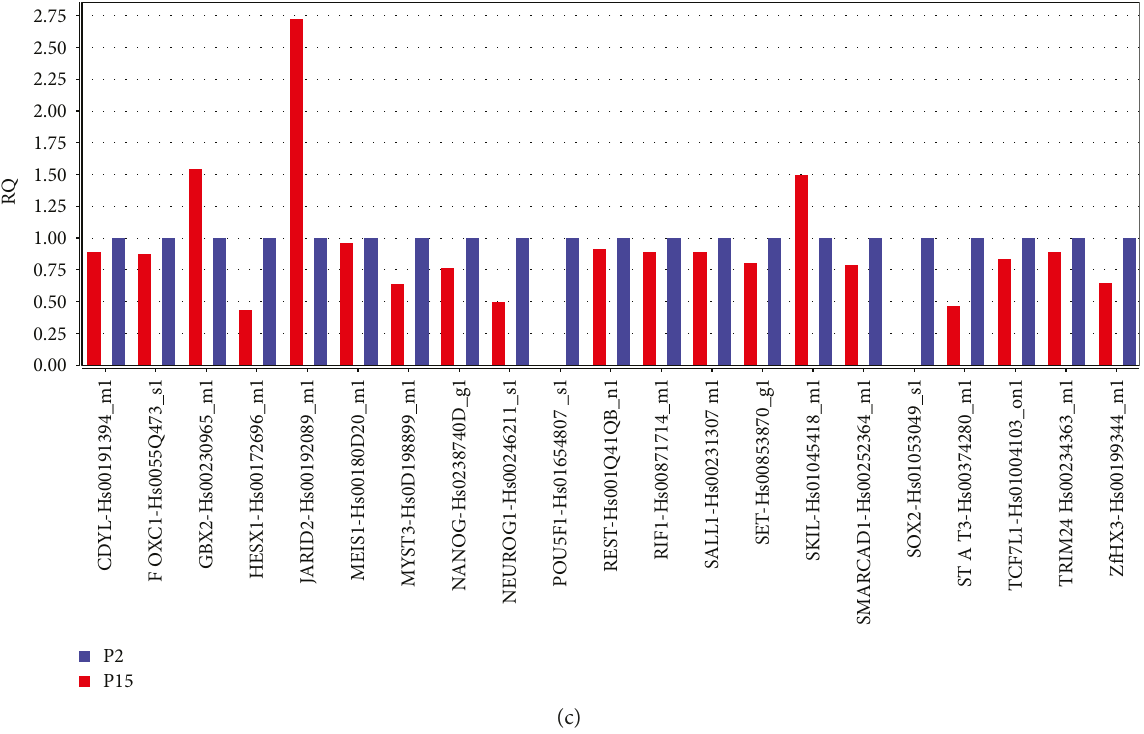
Figure 5: Relative gene expression folds by qRT-PCR. Bar charts show the signi fi cant relative gene expression folds in (a) hGMSCs, (b) hPDLSCs, (c) and hDPSCs at P15 under culturing conditions compared to P2. Expression levels of transcripts at P2 and P15 are shown in blue and red, respectively. DataAssist software was employed to run a global normalization analysis by using GAPDH, 18s, and HPRT1 as selected internal controls. The reported transcripts evidenced a p value < 0.05; p values were adjusted using Benjamini-Hochberg FDR correction.